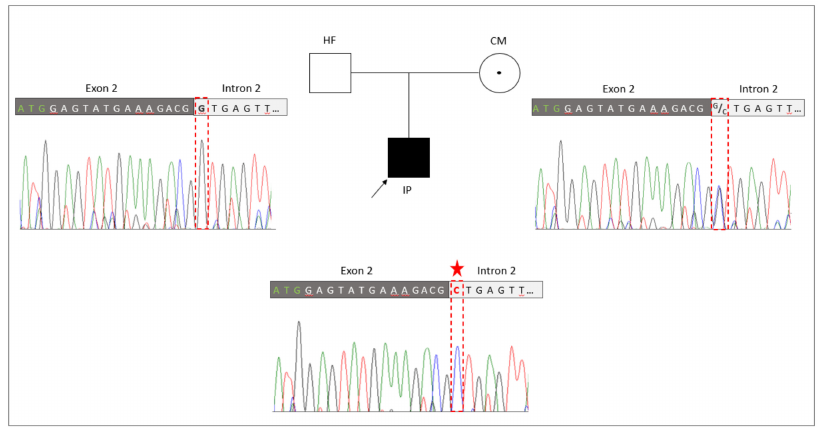
Figure 2. Genetic identification of the novel splice variant (NM_005676: c.17+1G>C, p.?) in RBM10 . The pedigree of the family with the TARP-affected child (IP), the healthy father (HF) and the